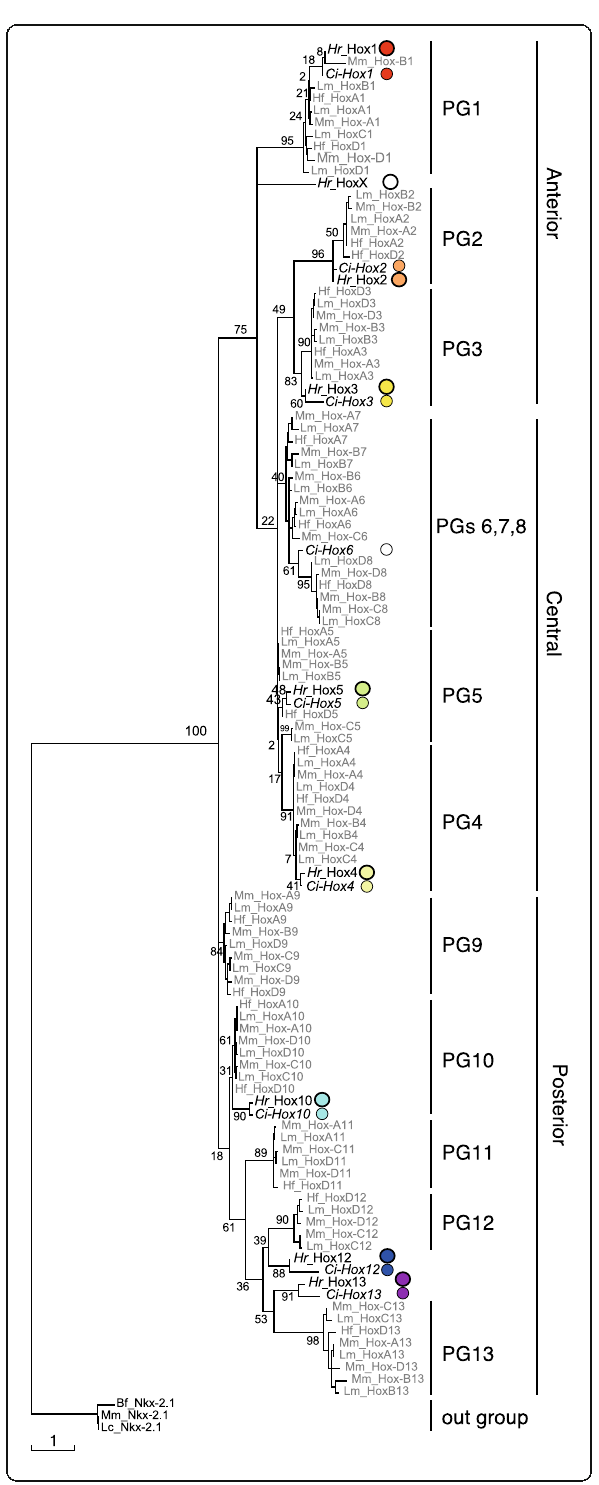
Fig. 1 Phylogenetic analysis of Hox gene candidates of Halocynthia roretzi . The ML tree was constructed using homeodomain sequences and the adjacent 20 N-terminal and seven C-terminal amino acid residues (Additional file 1: Figure S1) and MEGA5 software package. The percentage of 1000 replicated trees in which clustering of genes was supported is indicated at nodes. Within a clade consisting only of vertebrate Hox genes, the percentage is not indicated. Hr Hox gene candidates and Hox genes of Ciona intestinalis (Ci-Hox) are indicated by larger and smaller colored circles, respectively. Here, Hr Hox gene candidates are tentatively designated according to their Ci counterparts, except for HoxX, which did not show apparent orthology to Ci-Hox genes. The color-code indicates distinct paralog groups (PGs). Taxonomic abbreviations are Mm for Mus musculus , Lm for Latimeria menadoensis , Hf for Heterodontus francisci , Ci for Ciona intestinalis and Hr for Halocynthia roretzi . The bar at the bottom indicates one amino acid substitution per position in the